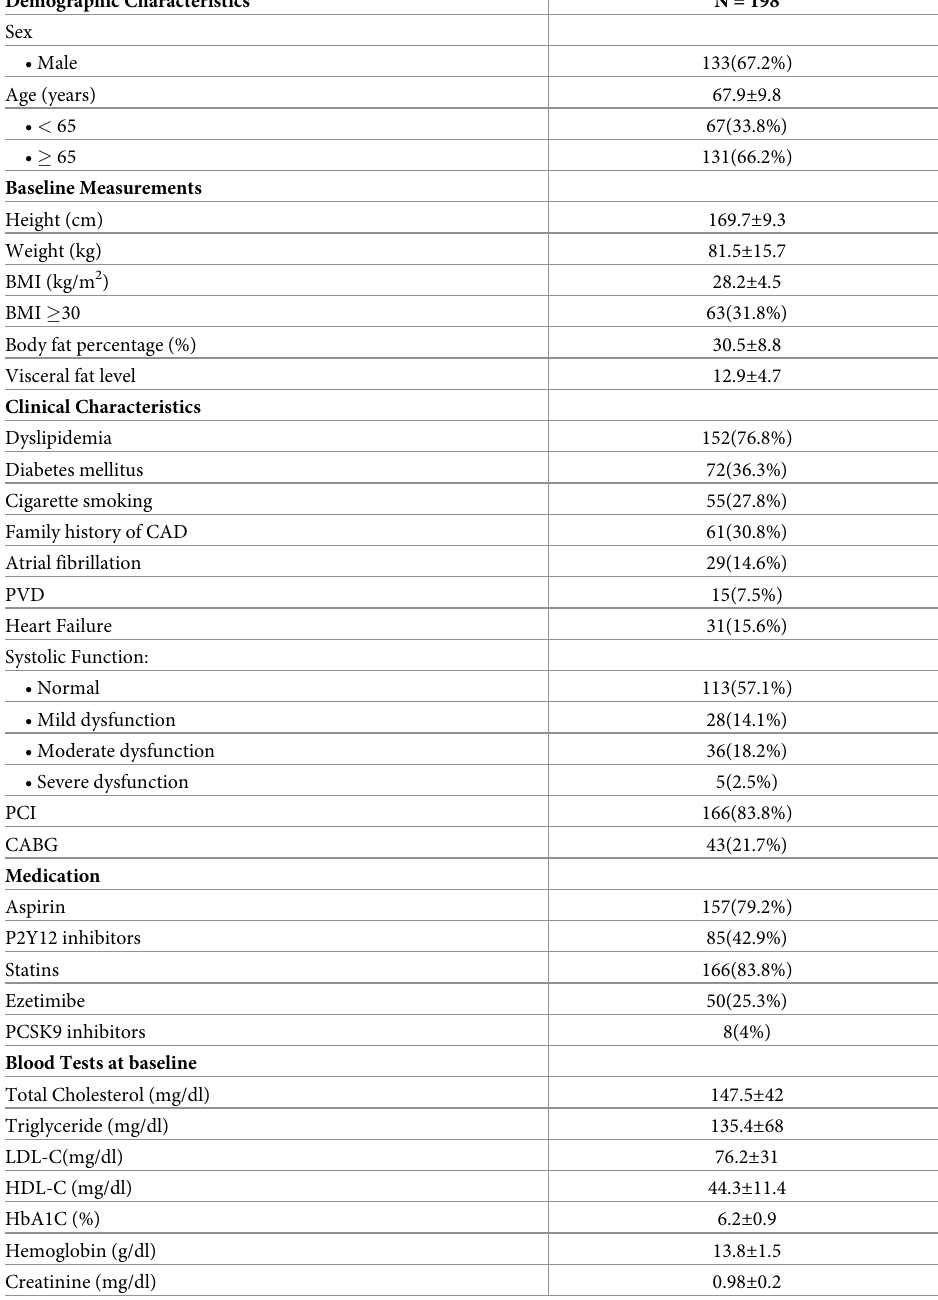
Table 1. Baseline patient characteristics and clinical